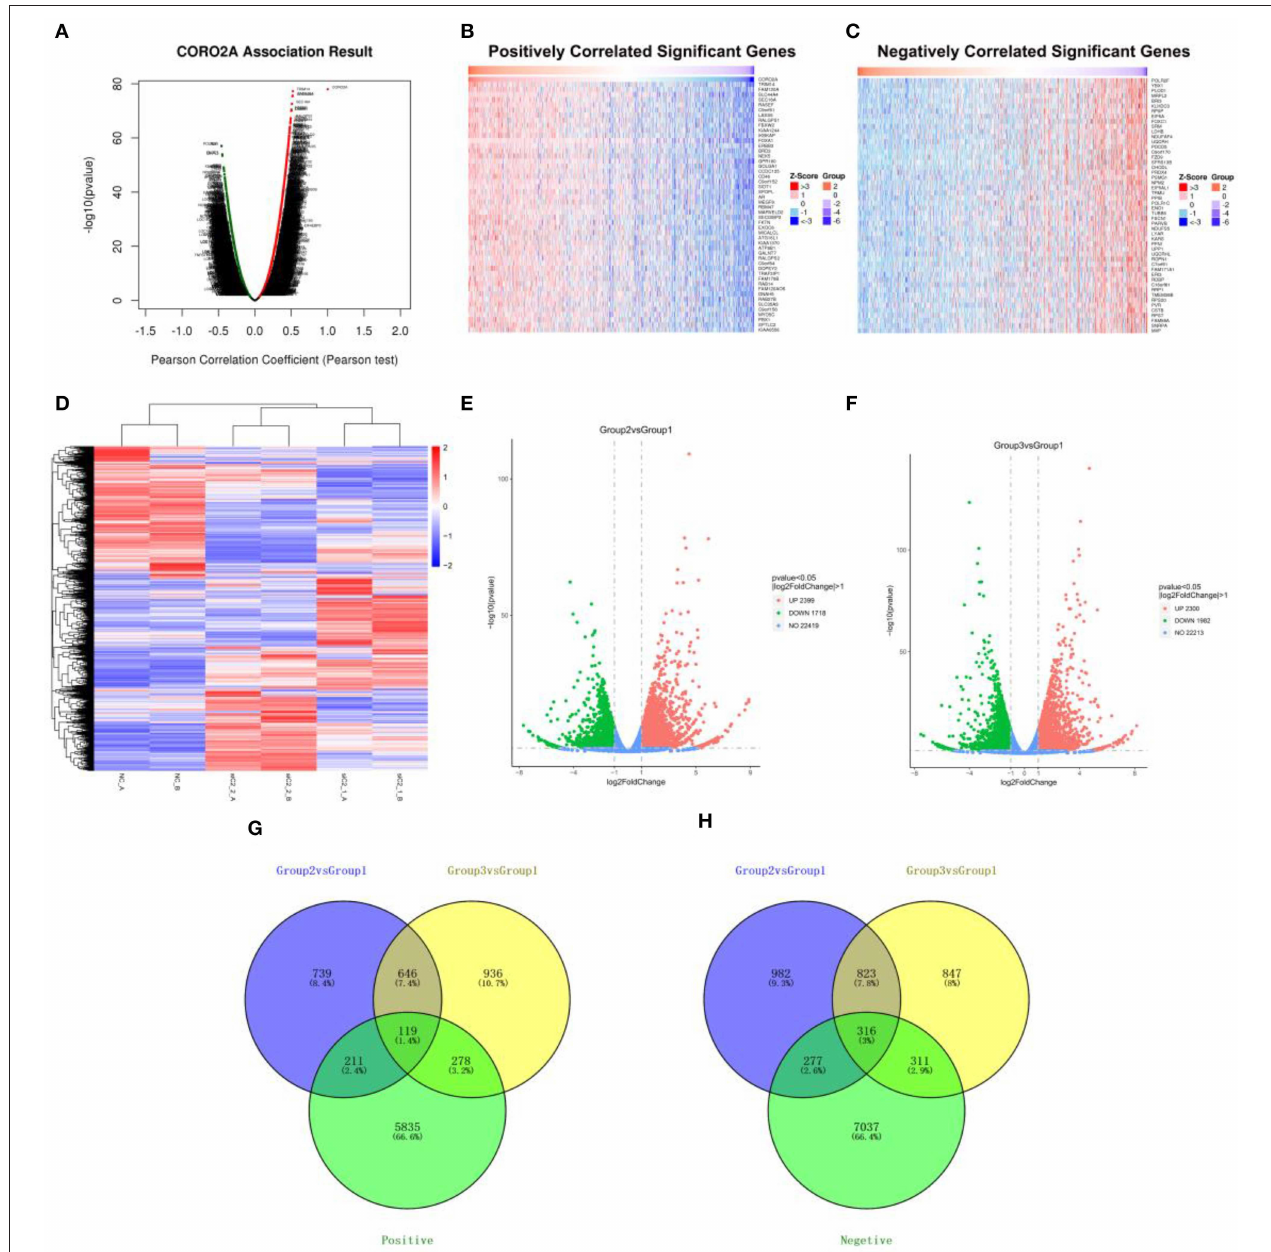
FIGURE 3 | Analyses of the intersection of CORO2A-coexpressed genes and differentially expressed genes after CORO2A silencing in human breast cancer. (A) CORO2A-coexpressed genes in breast cancer were analyzed by Pearson test (LinkedOmics). (B) TOP 50 genes positively correlated with CORO2A expression in breast cancer (LinkedOmics). (C) TOP 50 genes negatively correlated with CORO2A expression in breast cancer (LinkedOmics). Red represents genes positively correlated with CORO2A expression, while green represents genes negatively correlated with CORO2A expression. (D) Shows a heat map from hierarchical clustering of differentially expressed genes in CORO2A-knockdown BT549 cells vs. BT549 control cells (RNA-seq). Red color represents upregulated genes and blue color represents downregulated genes. Each row represents a single gene. (E,F) show the Volcano plots of differentially expressed genes after CORO2A silencing (RNA-seq). Red color represents upregulated genes and blue color represents downregulated genes. (E) Volcano plots of Group2 vs. Group1; (F) Volcano plots of Group3 vs. Group1. Panels (G,H) are Venn diagram depicting the intersecting genes. (G) Venn diagrams of intersecting genes of downregulated genes after CORO2A silencing and genes positively correlated with CORO2A expression; (H) Venn diagrams of intersecting genes of upregulated genes after CORO2A silencing and genes negatively correlated with CORO2A expression. The blue circle and the yellow circle represent the differentially expressed genes between CORO2A-knockdown BT549 cells vs. BT549 control cells, and the green circle represents CORO2A-coexpressed genes. siC2_1_A or siC2_1_B: transfected with CORO2A siRNA-1 (si-CORO2A-1); siC2_2_A or siC2_2_B: transfected with CORO2A siRNA-2 (si-CORO2A-2); NC_A or NC_B: transfected with unspecific siRNA; Group2 vs. Group1: comparison of group transfected by si-CORO2A-1 and group transfected by si-NC; Group3 vs. Group1: comparison of group transfected by si-CORO2A-2 and group transfected by si-NC; Positive: genes positively correlated with CORO2A expression; Negative: genes negatively correlated with CORO2A expression.